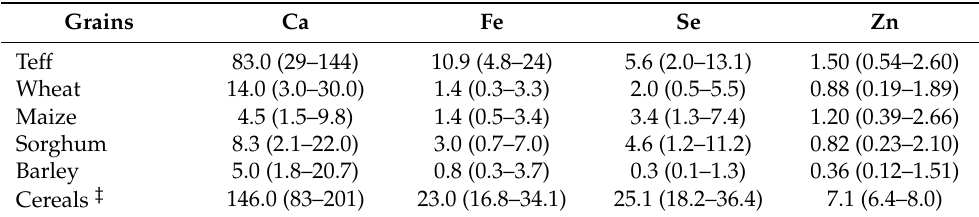
Table 2. District-level dietary mineral micronutrient supplies (mg capita − 1 day − 1 ) from staple cereals for adult women in